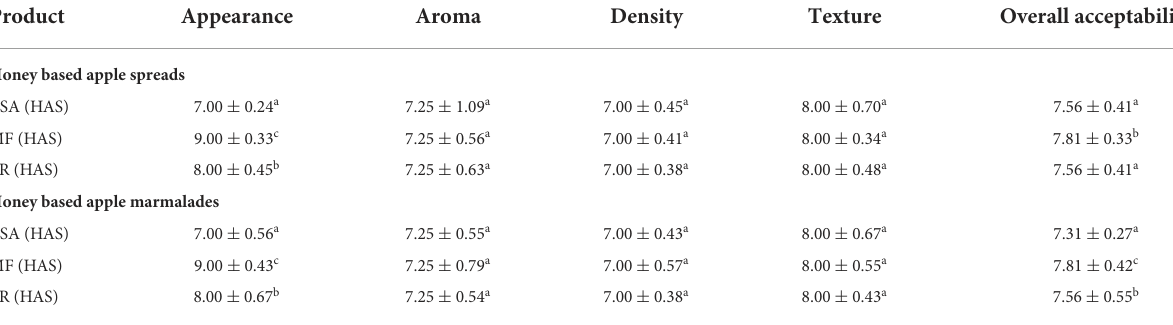
TABLE 3 Sensory analysis of honey based apple spreads and